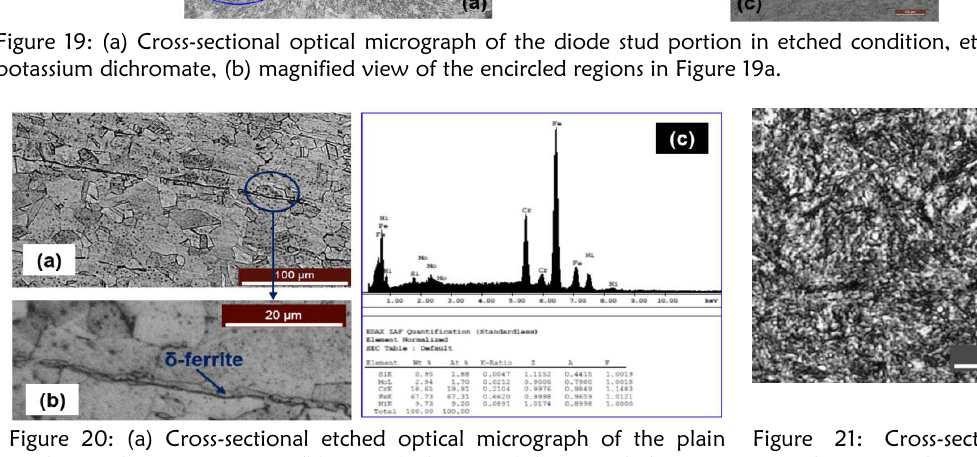
Figure 20: (a) Cross-sectional etched optical micrograph of the plain washer, etchant: aqua-regia, (b) magnified view of the encircled region showing chain like δ -ferrite, (c) EDS analysis of the base material for plain washer.